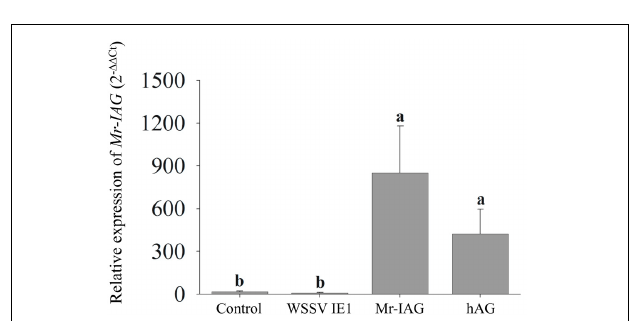
FIGURE 7 | qPCR analysis of Mr-IAG expression levels in Mr-IAG transduced M. rosenbergii primary cell cultures. The relative levels of Mr-IAG expression in uninfected cells, WSSV IE1-infected cells, and Mr-IAG-infected cells were determined by qPCR. hAG served as the positive control. For all samples n = 5. Different letters represent groups that are significantly different ( p < 0.05); error bars represent standard